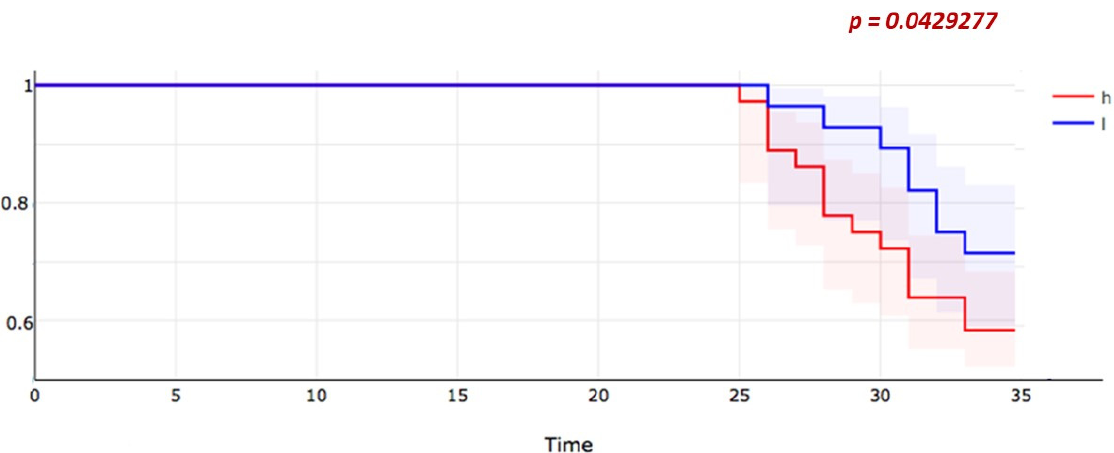
Figure 2. Worsening of CKD stage according to KDIGO classification in patients with LN divided by high or low level at DKK3 at baseline. DKK3 H N = 21 patients; high defined as >75th percentile of the distribution of DKK3 among patients with LN. DKK3 L N = 36 patients, low defined as <75th percentile of the distribution of DKK3 among patients with LN. (CKD = chronic kidney disease; KIDGO = Kidney Disease Improving Global Outcomes; LN = lupus nephritis; DKK3 = Dickkopf- related protein 3).